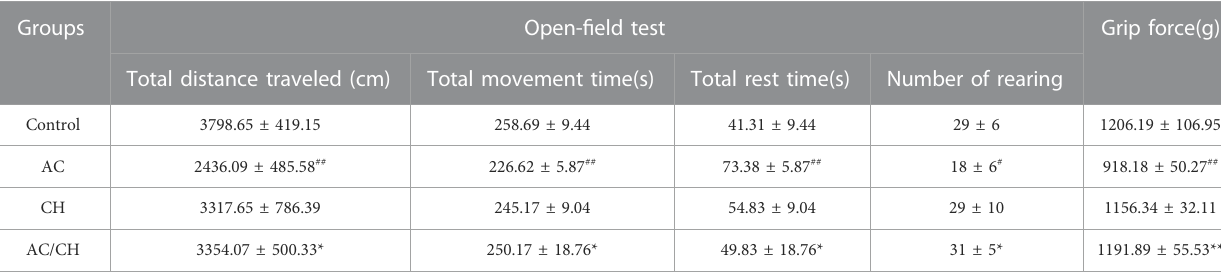
TABLE 4 Effect of Alangium chinense and the compatible herbs on the behavioral activity in rats.